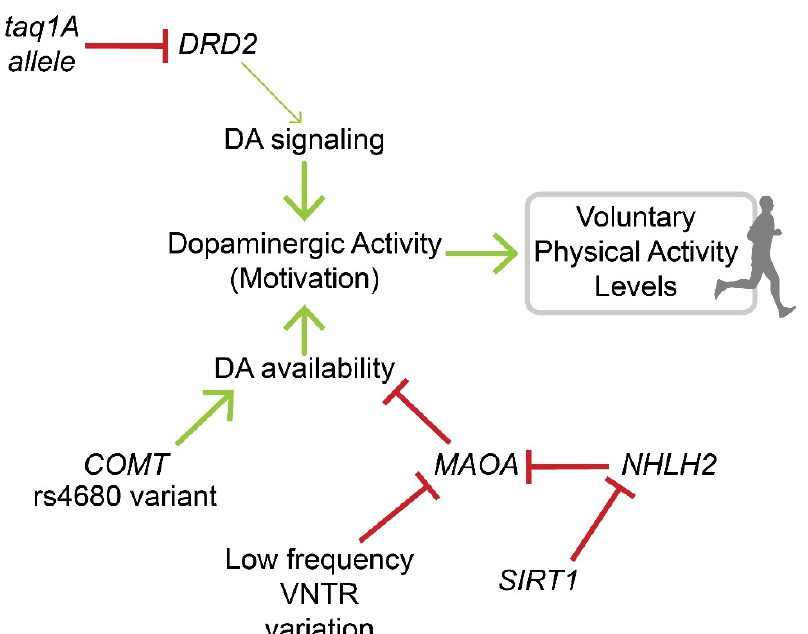
Figure 2. Genetic regulation of voluntary physical activity through dopamine pathways in the brain. A proposed model depicting genetic evidence-based potential biological mechanisms involved in the regulation of motivation for physical activity via dopamine-associated pathways (see text for explanation of genes shown; arrow head indicates procession, with the size of the arrow representing degree of procession; T head indicates inhibition/reduction).